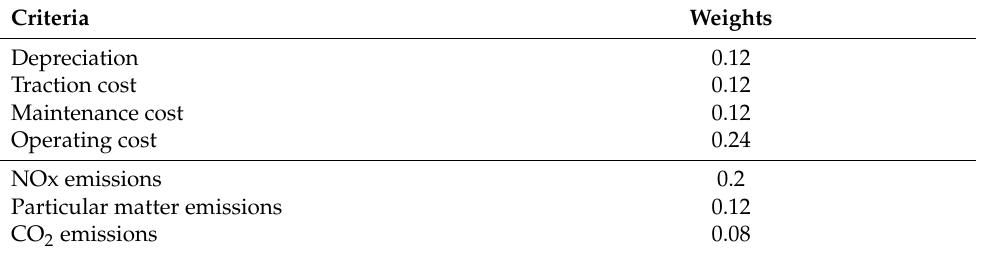
Table 14. Weights for the ELECTRE TRI model.